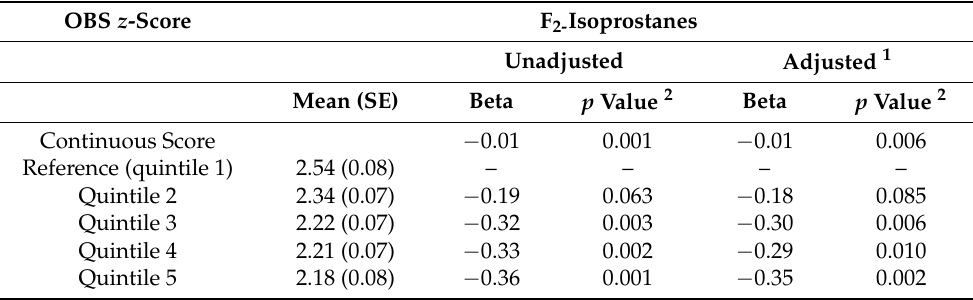
Table 3. Associations between oxidative balance score (OBS) during pregnancy and F2-isoprostanes ( n =